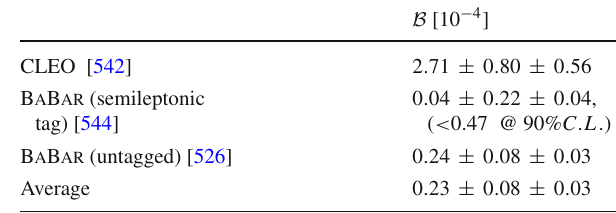
Table 88 Summary of exclusive determinations of B + → η (cid:7) (cid:12) + ν . The errors quoted correspond to statistical and systematic uncertain- ties,